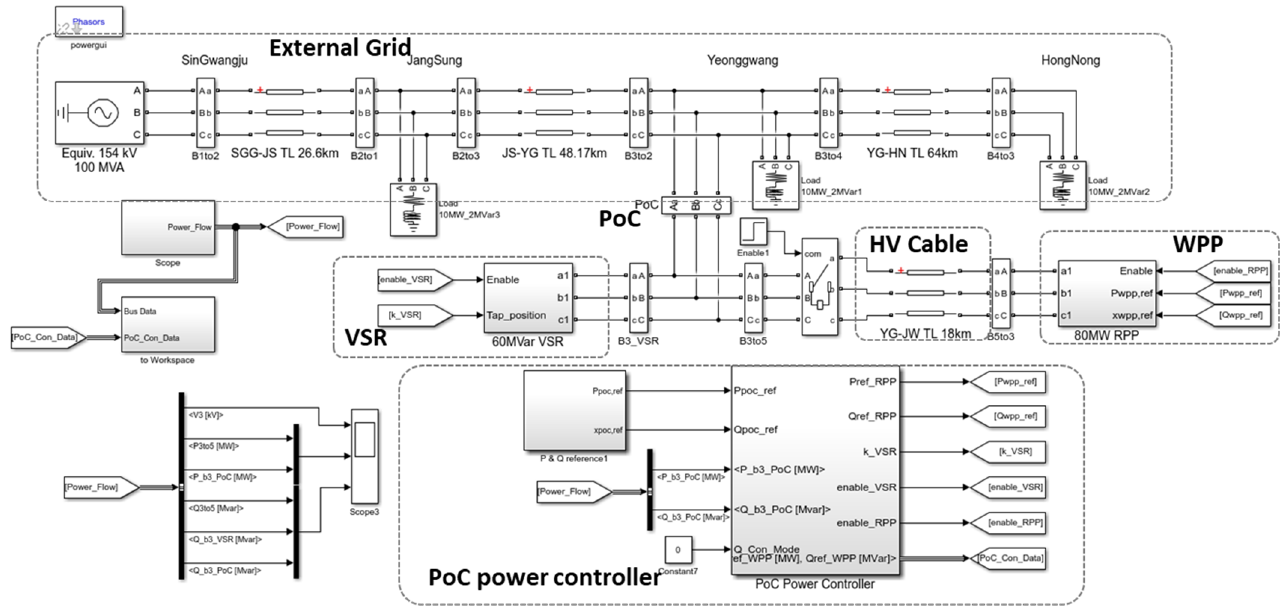
Figure 11. Simulation model of wind power plant with HV cable and VSR using MATLAB/Simulink.